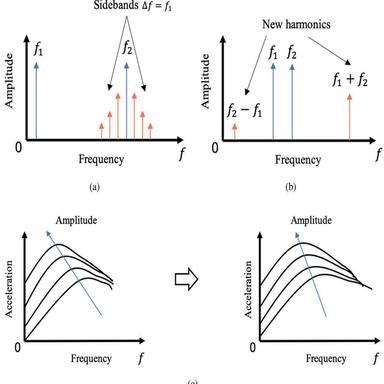
Spectrum characteristics of nonlinear elastic wave modulation methods: (a) NWMS, (b) Wave mixing, (c) NRUS.